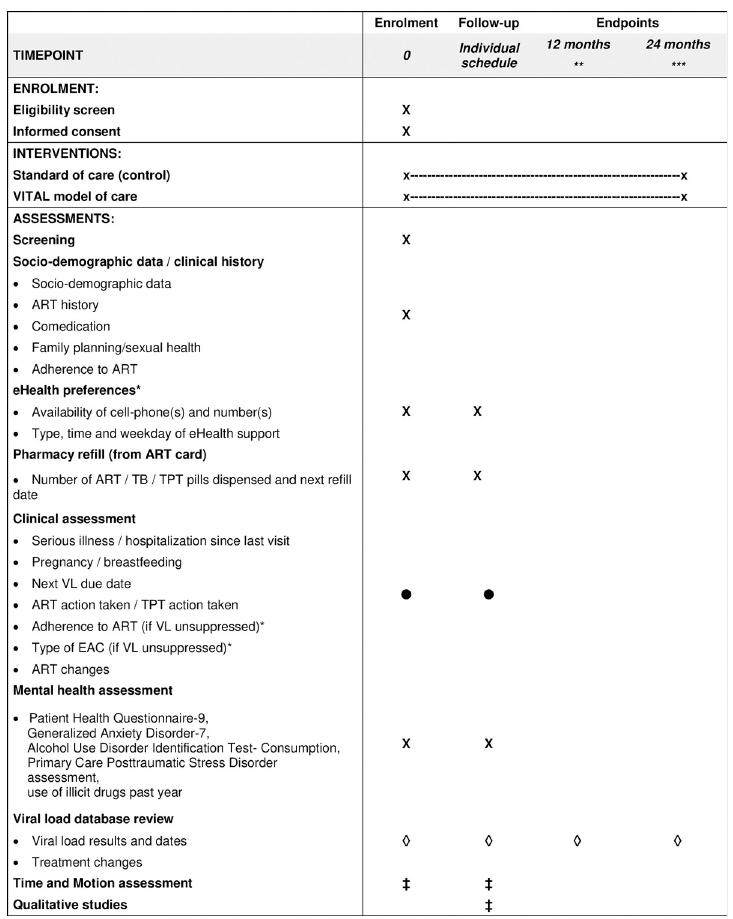
Fig 1. Spirit flow diagram: Schedule of enrolment, interventions, and assessment procedures. Symbols correspond to the responsible person for the assessment or task: X: VITAL study team, •: Clinic staff, ^ : VITAL data management team, ‡: Other VITAL study team members. � in VITAL intervention clinics only; �� 12 months window; ��� 24 months window. TB: Tuberculosis; TPT: Tuberculosis preventive therapy; VL: Viral load; EAC: Enhanced adherence